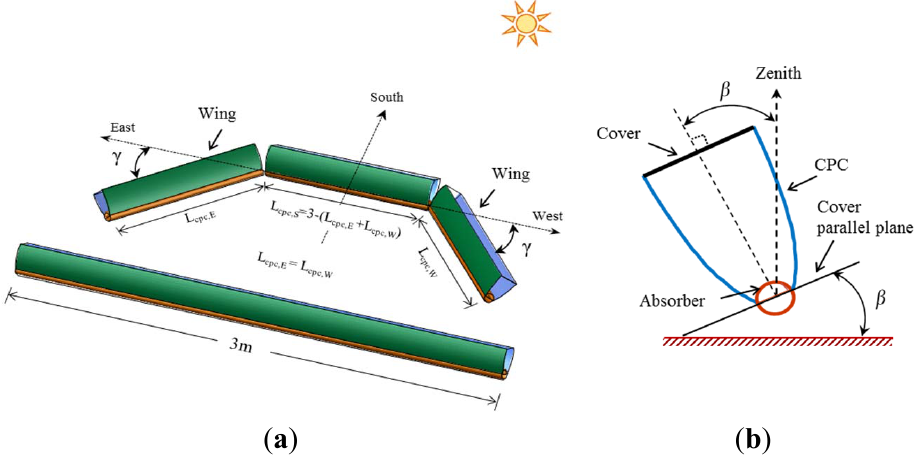
Figure 1. Description of the proposed compound parabolic concentrator (CPC): ( a ) difference in shape between proposed CPC with angled wings (upside) and linear CPC (downside); and ( b ) CPC geometry.